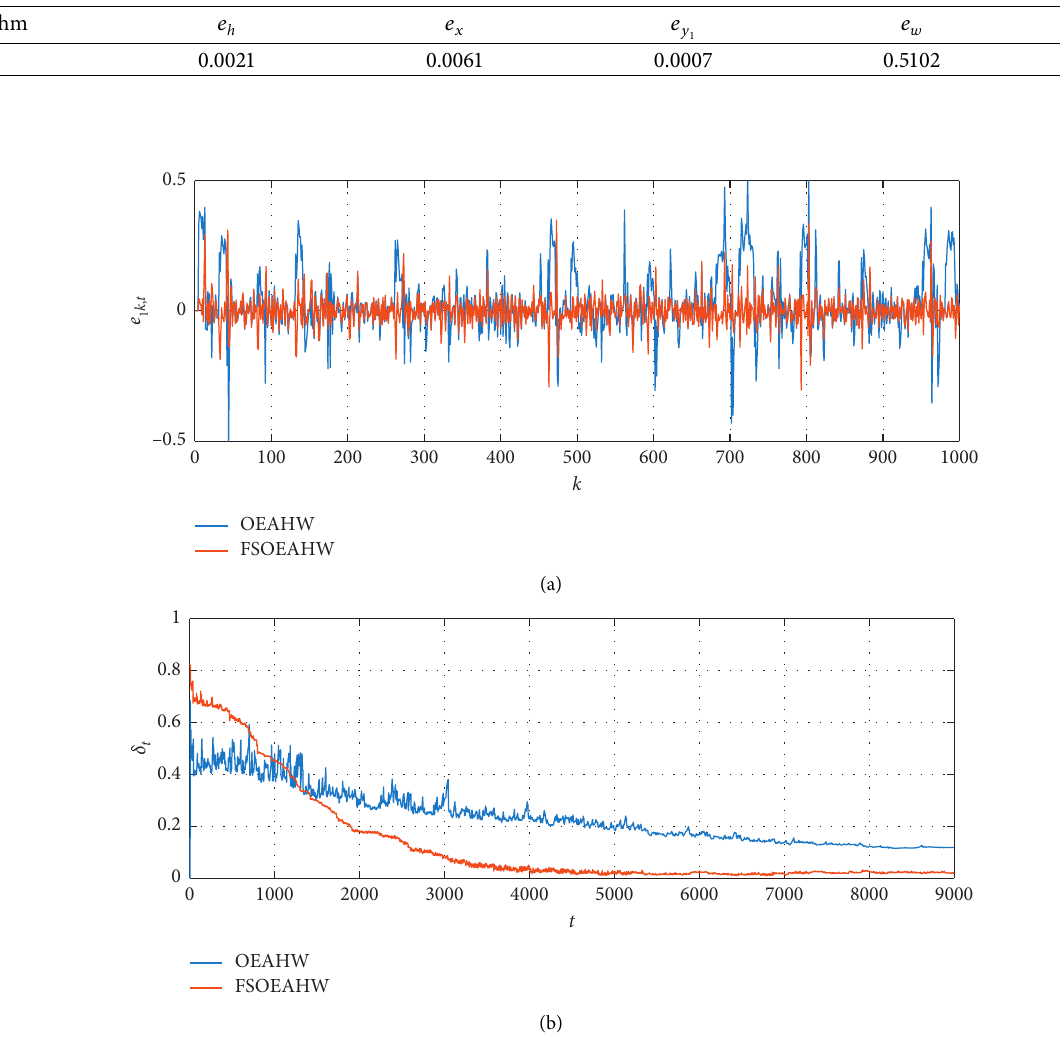
Table 2: Estimation errors for the FSOEAHW model using IBPG algorithm.